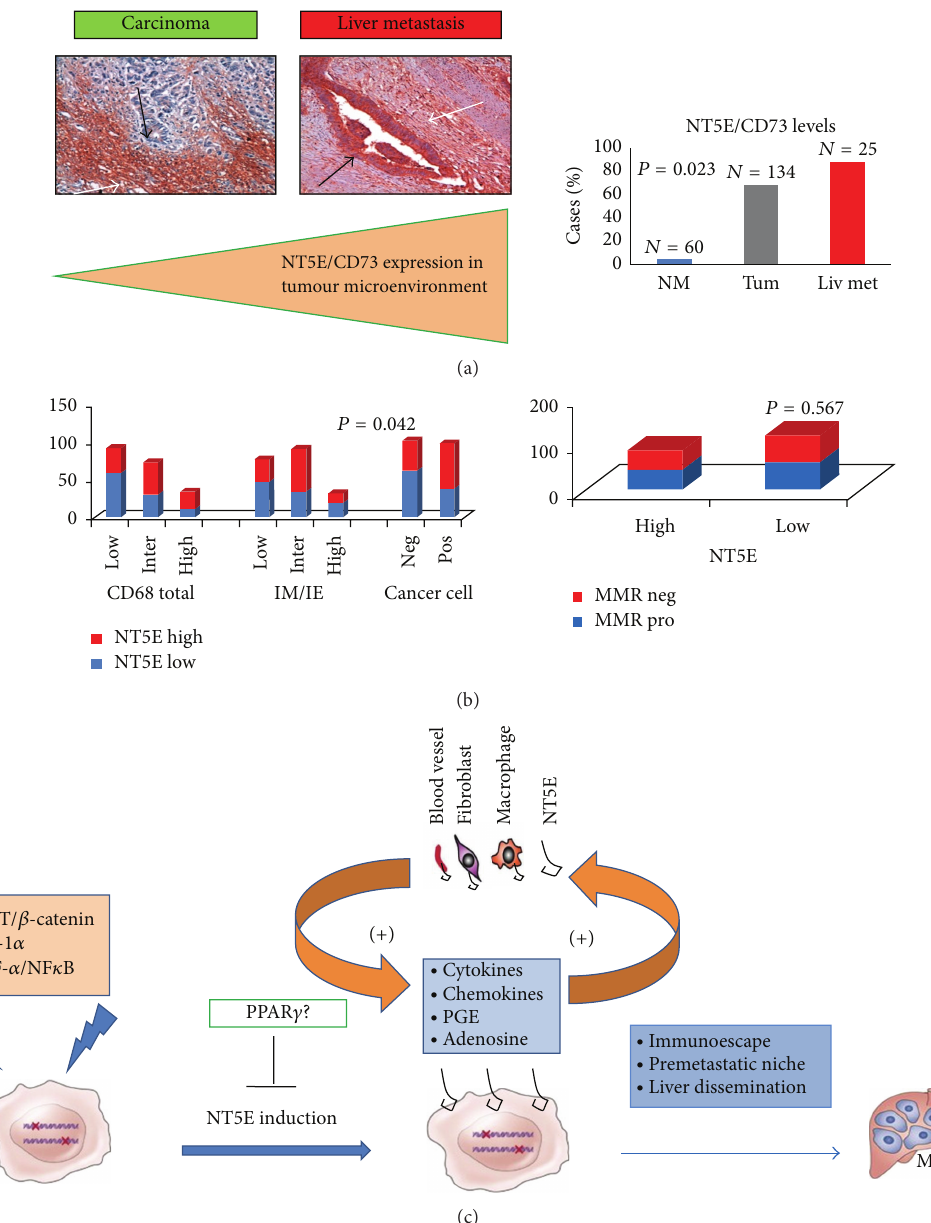
Figure 3: NT5E/CD73 facilitates escape from immune-surveillance and orchestrates the tumour-stroma interplay to promote cancer growth and metastasis. (a) Representative images of NT5E/CD73 immunostaining in a primary carcinoma and corresponding liver metastasis. White and black arrows indicate the immunostaining in the stromal compartment and malignant colonic cells, respectively, magnification 10X. (b) NT5E/CD73 immunostaining is higher in liver metastatic tissues than in primary tumours or normal colonic mucosa and significantly correlates with CD68 infiltration. NT5E/CD73 expression is not correlated with the MMR status in our cohort of CRC patients. (c) Schematic drawing of the proposed mechanism(s) involved in metastasis-promoting actions of NT5E/CD73. In physiological conditions, NT5E/CD73 hydrolyzes AMP to adenosine, an important mediator that binds A2A receptors on activated CD4 effector T-cells, decreasing theirproliferationandcytokineproduction,hencemediatingimmunosuppressiveeffects.NT5E/CD73isexpressedinavarietyofstromalcells (macrophages, endothelial cells, B-lymphocytes, and Treg-cells). A variety of oncogenic pathways can induce ectopic NT5E/CD73 expression in CRC cells, enhancing paracrine/autocrine interactions (activation of A2B receptors) between malignant colonic, hematopoietic, and nonhematopoietic cells to sustain immunosurveillance escape and cancer cell migration. PPAR 𝛾 (peroxisome proliferator-activated receptor gamma) has been suggested as a possible NT5E/CD73 antagonist through still unknown mechanisms. IE: intraepithelial; IM: invasive margin; Liv Met: liver metastases; MMR pro and MMR neg indicate MMR proficient and deficient tumours, respectively. The 𝑃 value is reported in each